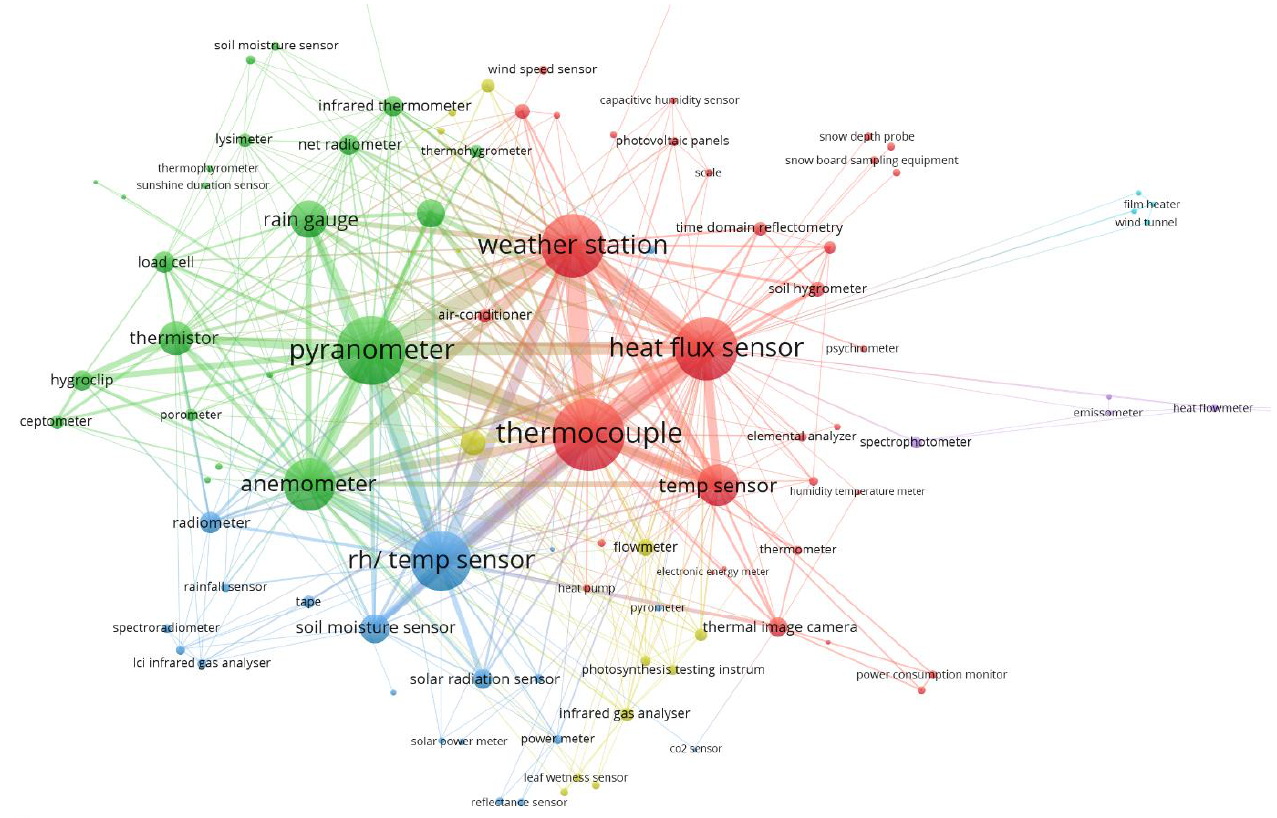
Figure 15. Bibliography network of the sensors used in the reviewed articles.